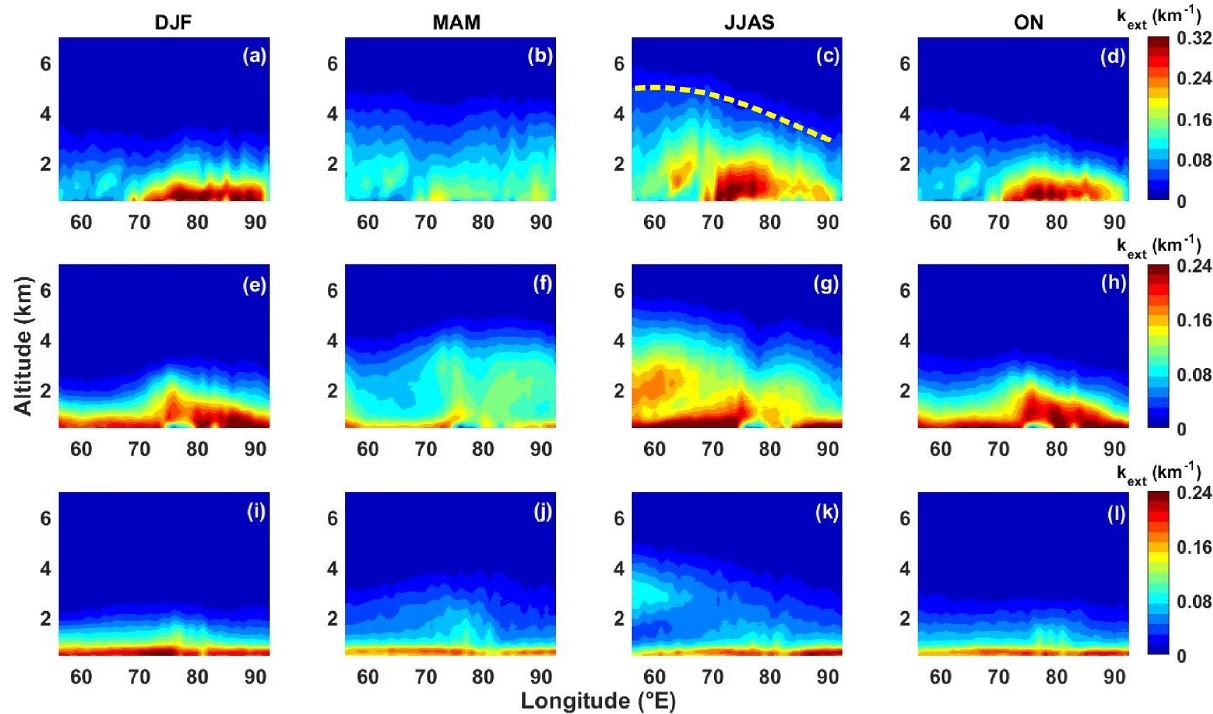
Figure 3. Zonal variation in the CALIOP aerosol extinction coefficient ( k ext ) profiles for SR1 (top panels), SR2 (middle panels), and SR3 (bottom panels) sub-regions. Each column corresponds to a particular season, as marked above them. The dotted yellow line in Fig. 3c illustrates the eastward gradient in the extent of the vertical intrusion of